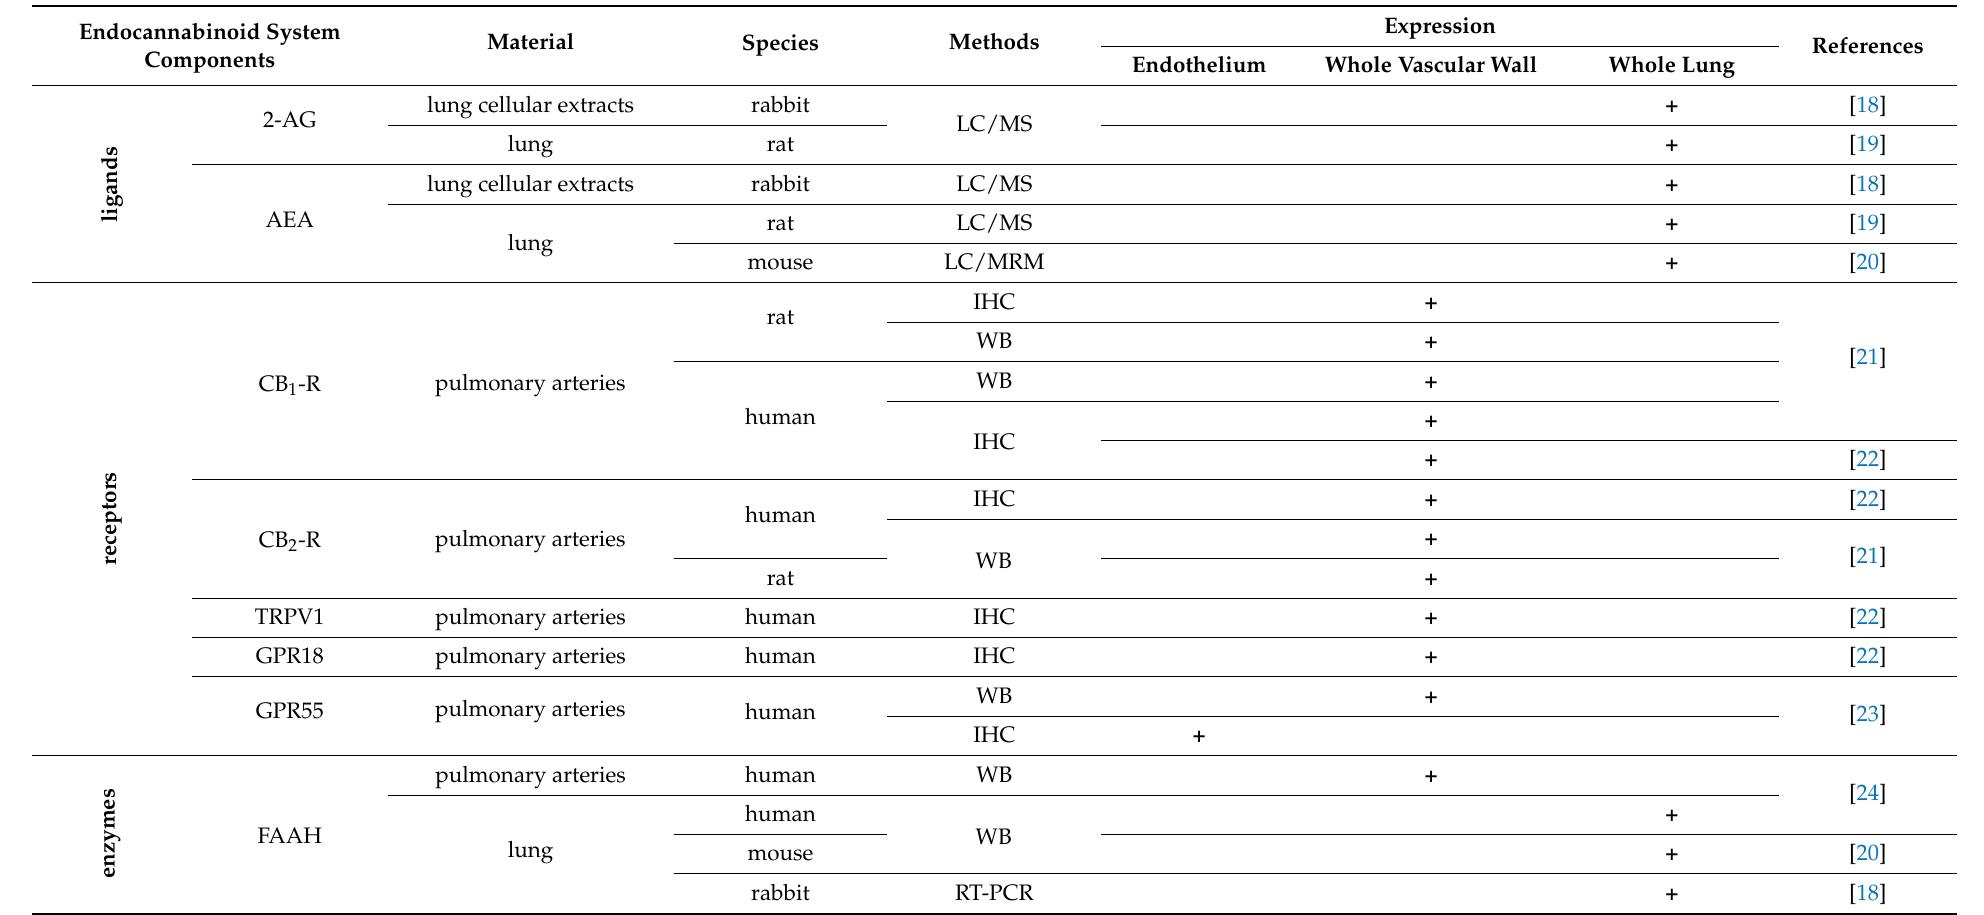
Table 1. Expression of the selected components of the endocannabinoid system in pulmonary circulation/lung